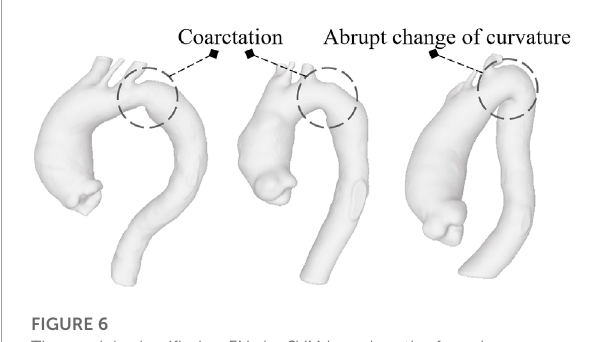
FIGURE 6 The models classified as FNs by SVM based on the four shapes features: the first two report aortic coarctation while the third shows a reduced radius of curvature between the arch and descending